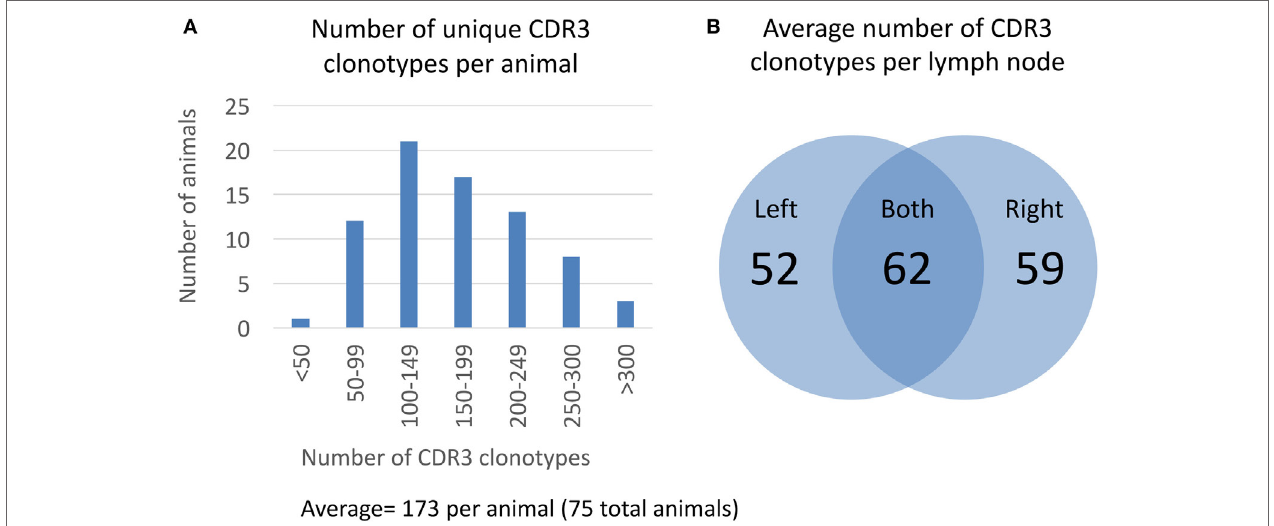
FigUre 2 | Clonotype diversity in 75 OmniFlic animals. (a) Distribution of CDR3 clonotypes per animal from a total of 75 OmniFlic animals. The number of unique CDR3 clonotypes per animal ranged from 47 to 433 with a mean of 173. (B) Overlap of CDR3 clonotypes between lymph nodes of the same animal. The 173 average CDR3 clonotypes per animal, 62 are common to both lymph nodes, and the remaining 111 are unique to 1 lymph node, on